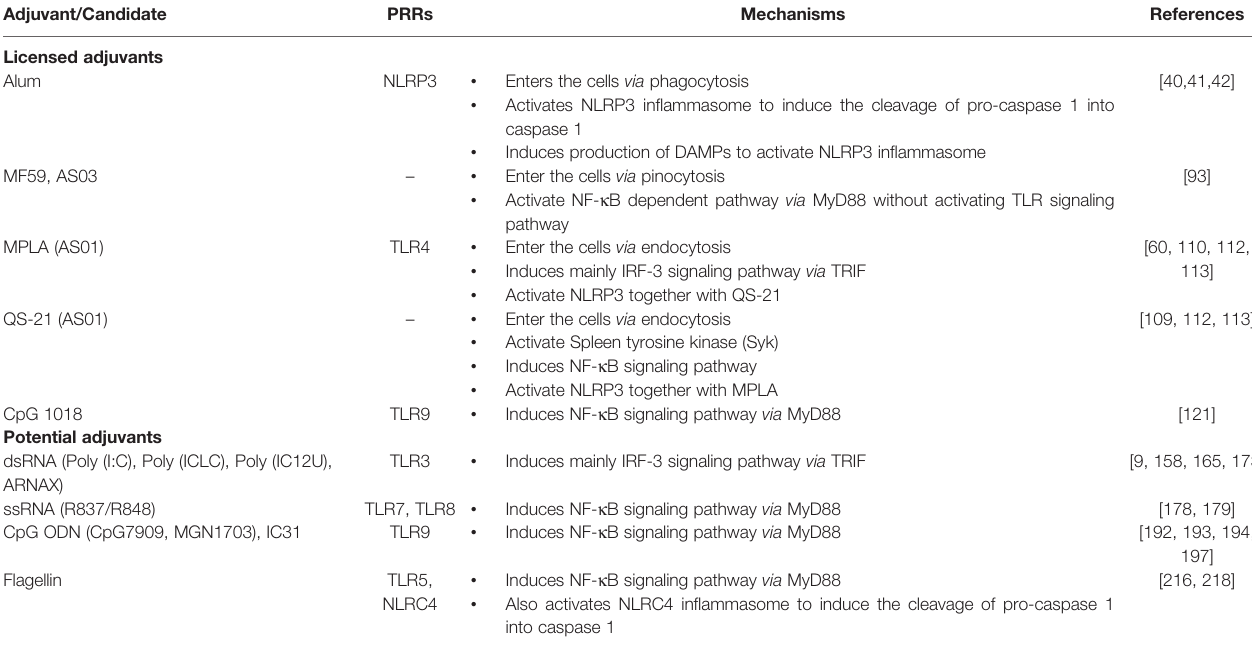
TABLE 1 | PRR adjuvant candidates and their activation